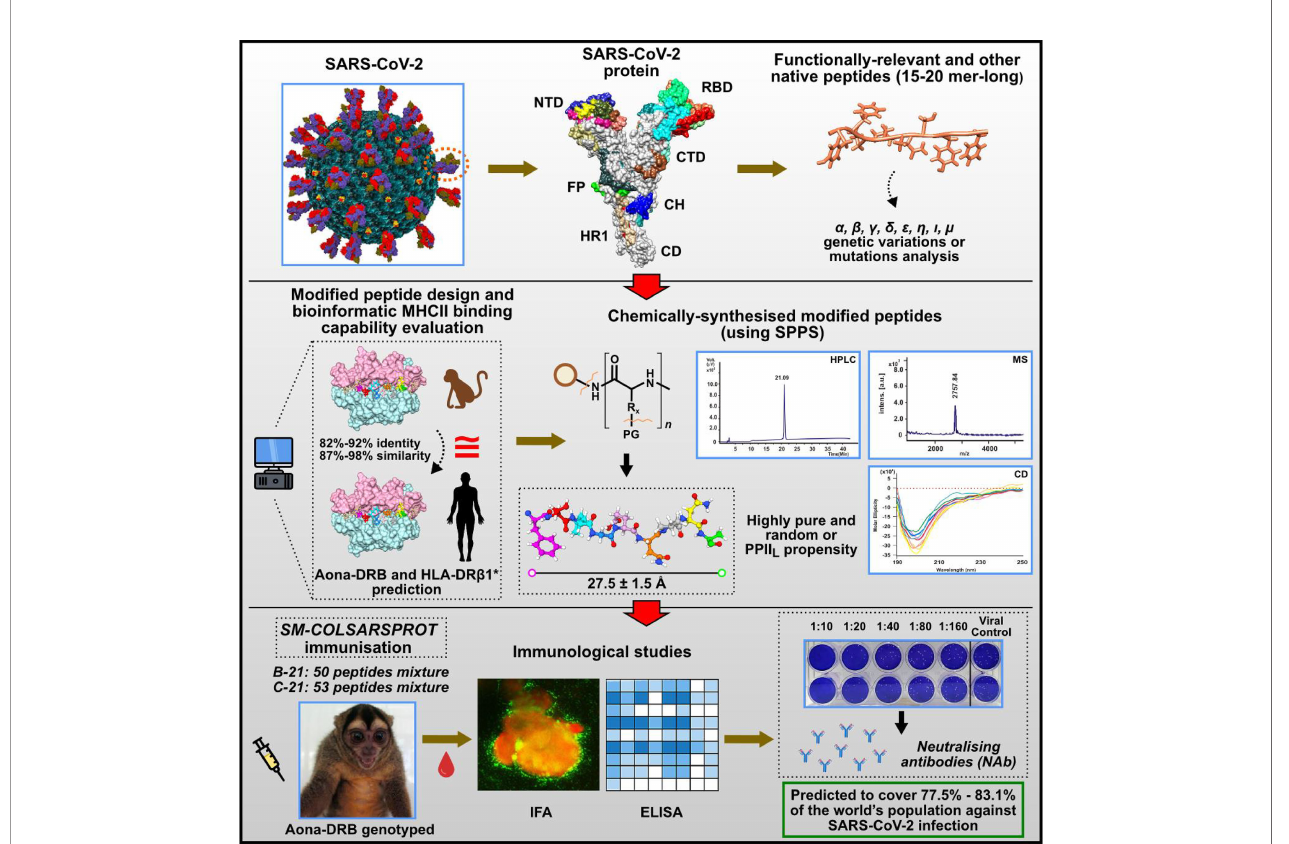
FIGURE 13 | Summary of the entire process involved in obtaining SM-COLSARSPROT. Top panel: selecting functionally relevant fragments from the main SARS- CoV-2 proteins involving genetic variations. Middle panel: peptide design, production, and characterisation; Aona DRB and HLA-DR b 1* prediction. Bottom panel: immunological